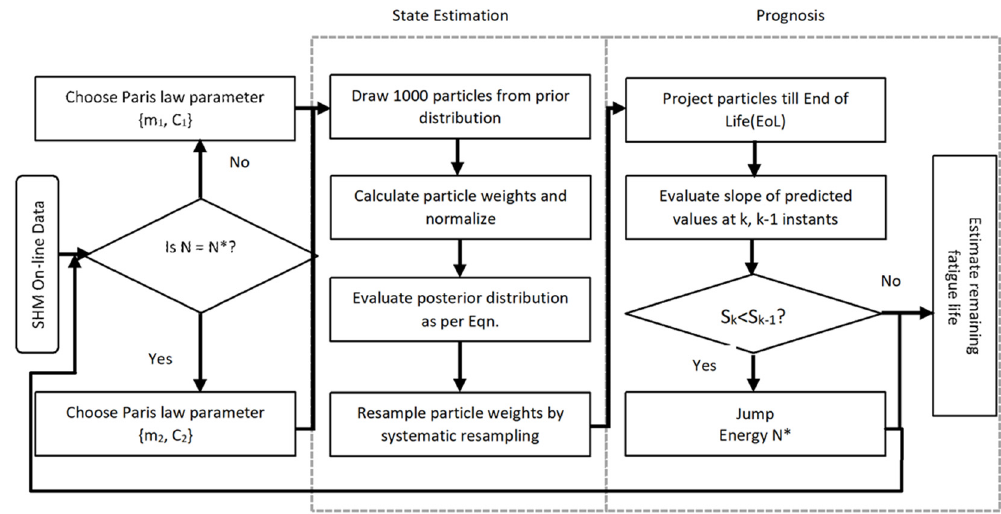
Figure 2. The proposed online prognostic framework using particle filter